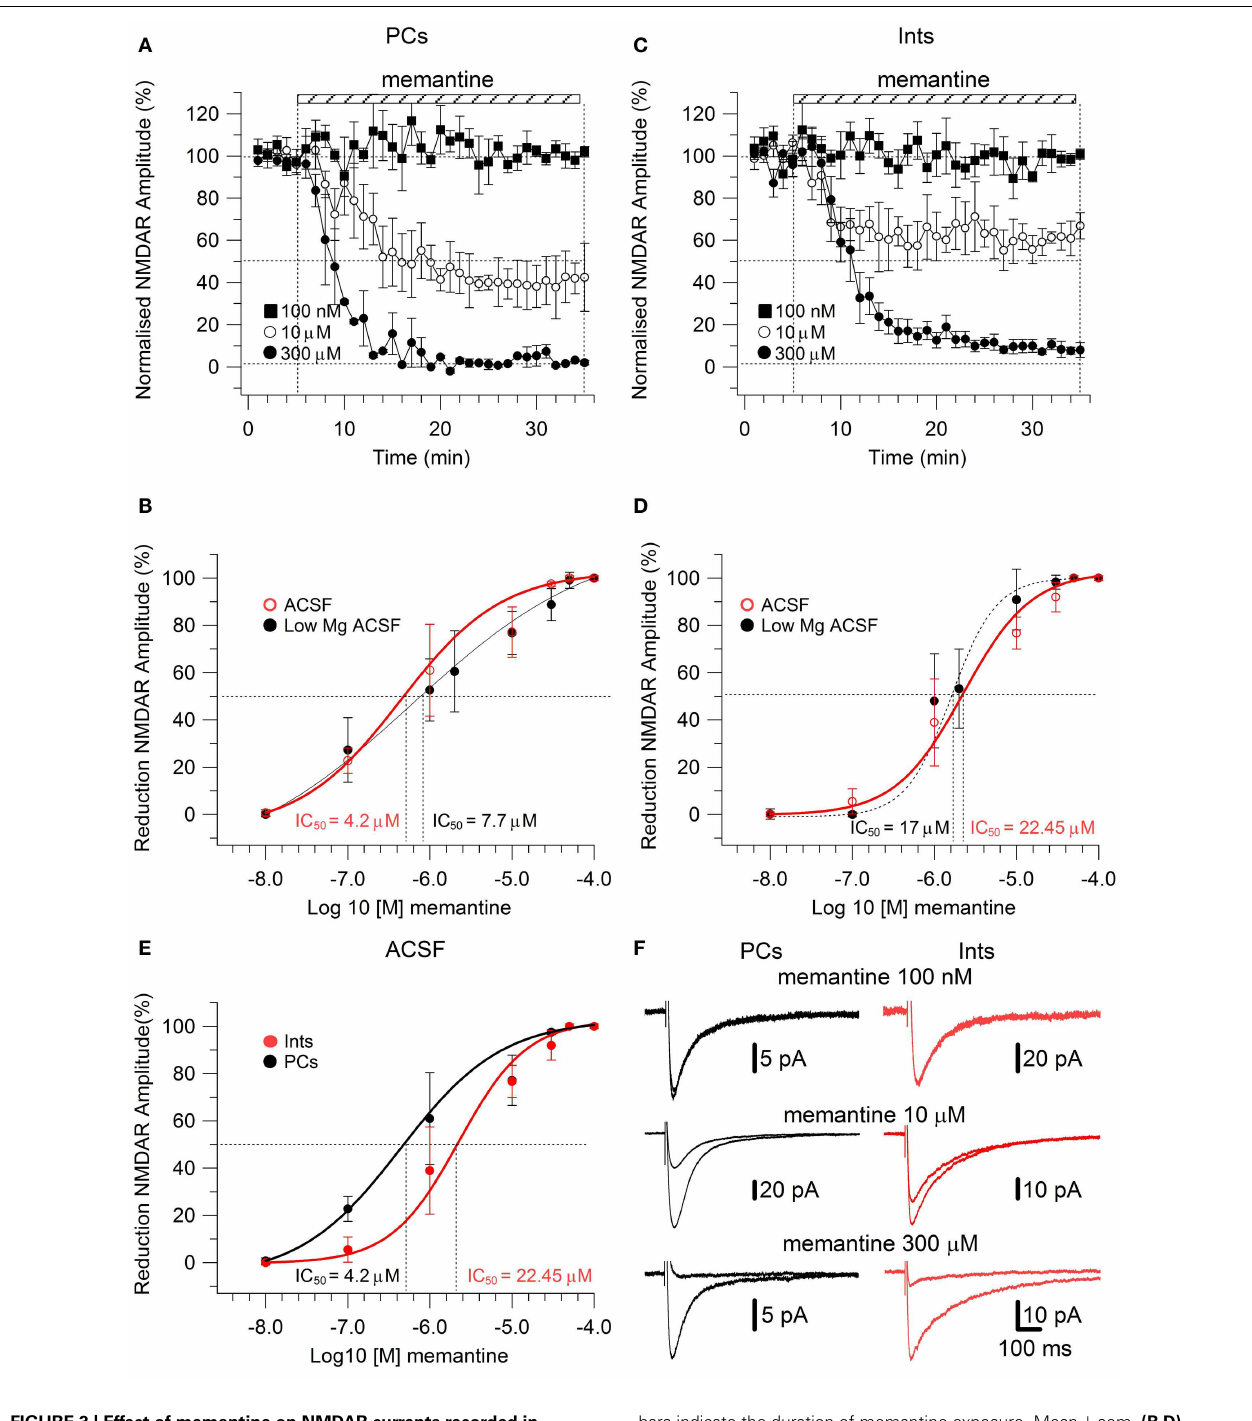
FIGURE 3 | Effect of memantine on NMDAR currents recorded in presence of Mg 2 + atV m =− 30, in PCs and Ints in the CA1 region of the hippocampus. (A–C) Time-course of memantine-induced reduction on the NMDAR current amplitude in PCs and Ints, respectively. Normalized NMDAR current amplitudes (%) are plotted as a function of time for memantine concentrations of 100nM (full square), 10 µ M (empty circle), 300 µ M (full circle). Each point (one every min) is the average of six points (stimulations every 10s).The